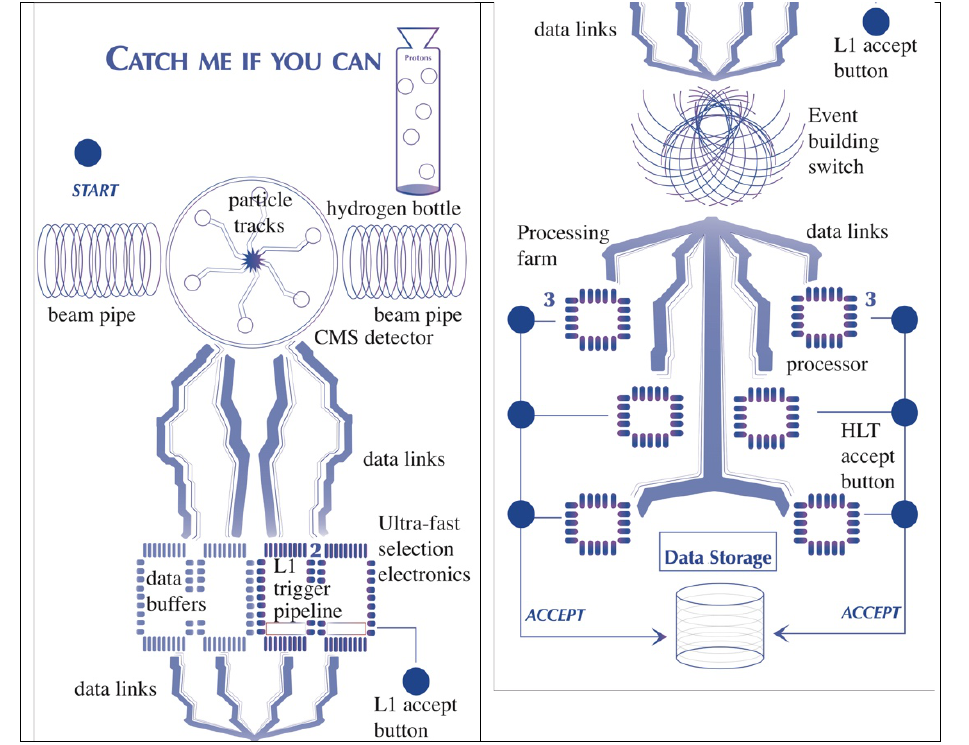
Fig. 3. Main elements of the game, top half (left) and bottom half